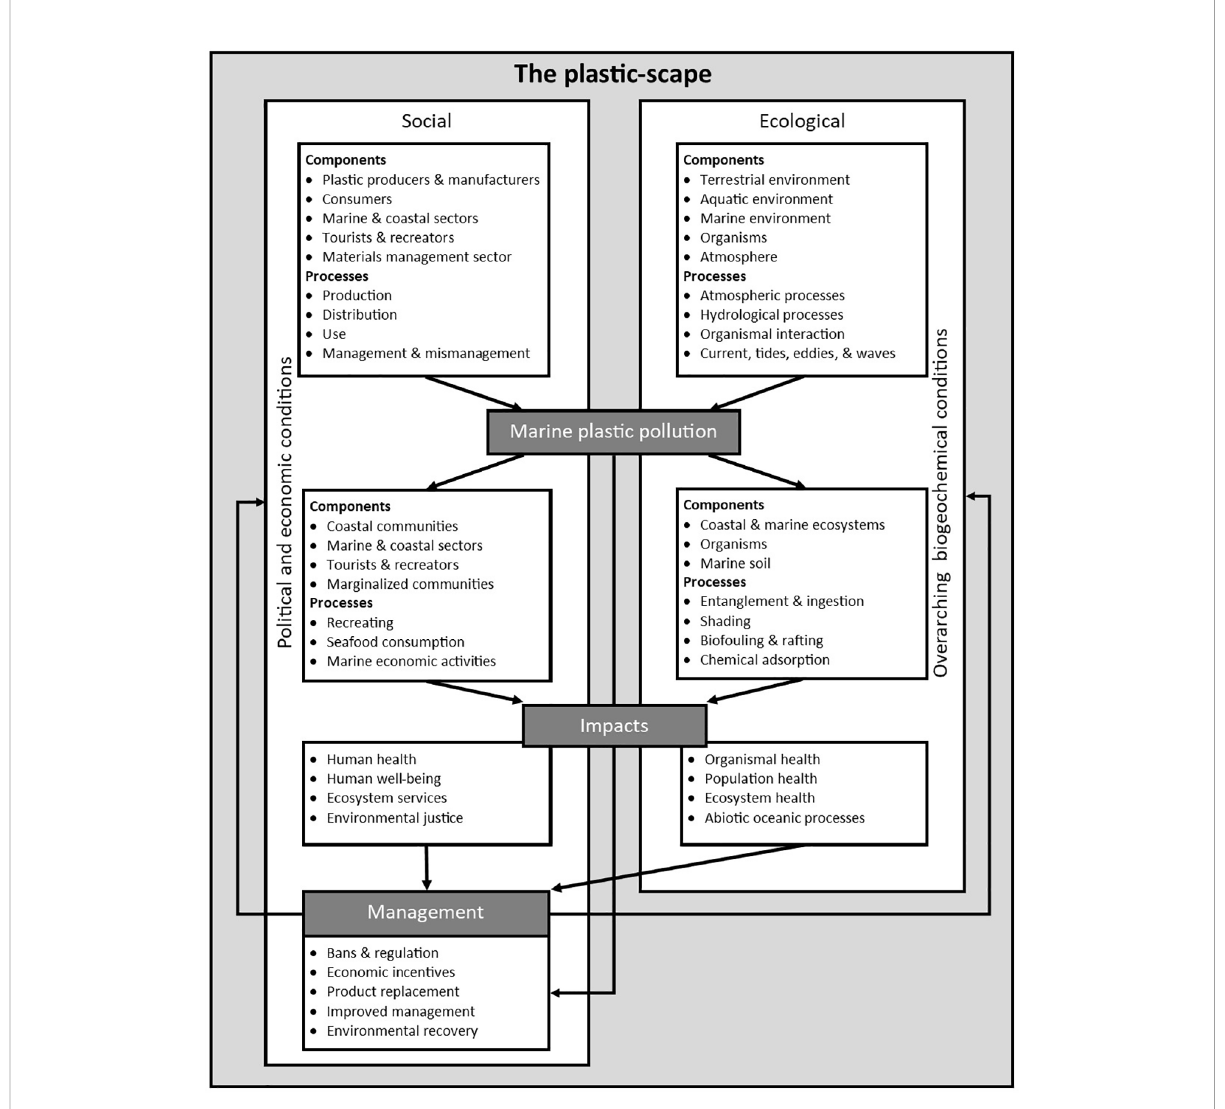
FIGURE 1 A conceptual model of the plastic-scape. The fi rst set of social and ecological components and processes drive the creation and distribution of marine plastic pollution. The second interact with marine plastic pollution to drive the social-and ecological impacts of marine plastic